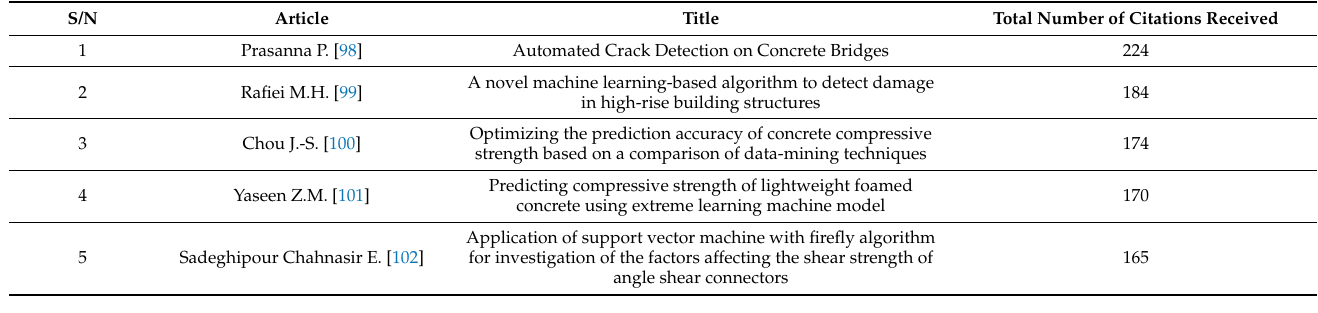
Table 4. List of top 5 documents in terms of citations received up to May 2022.